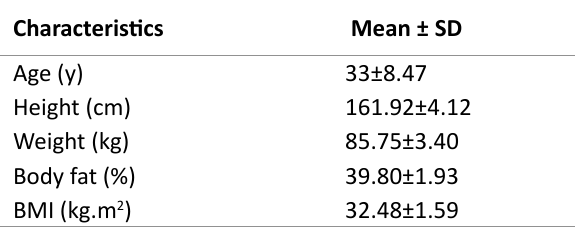
Table 1. Characteristics of the study